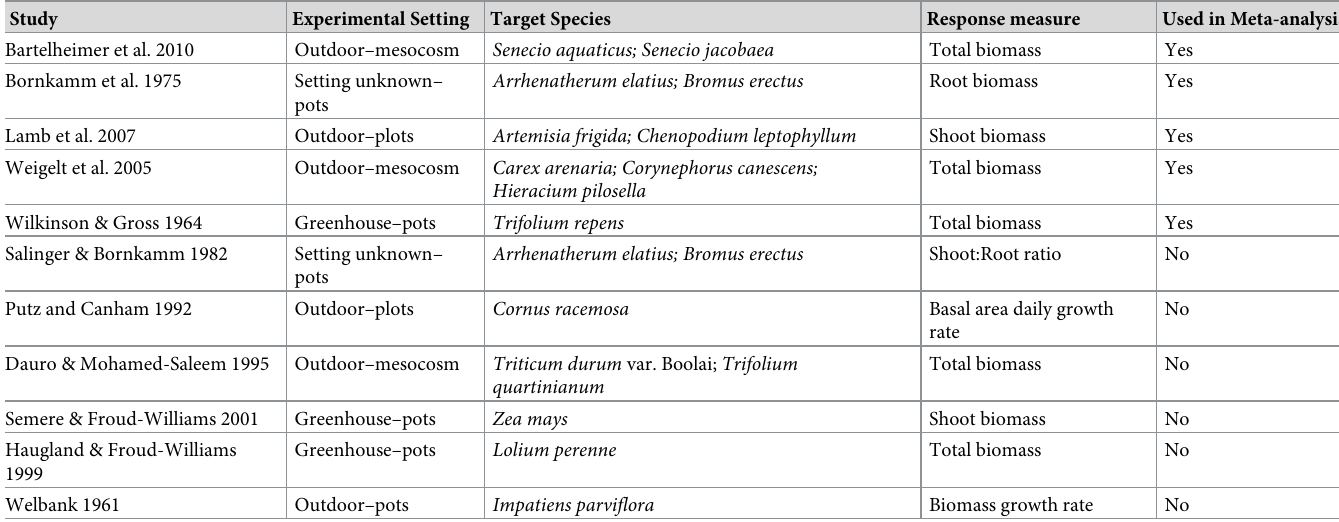
Table 1. Characteristics of studies assessed in this systematic review.